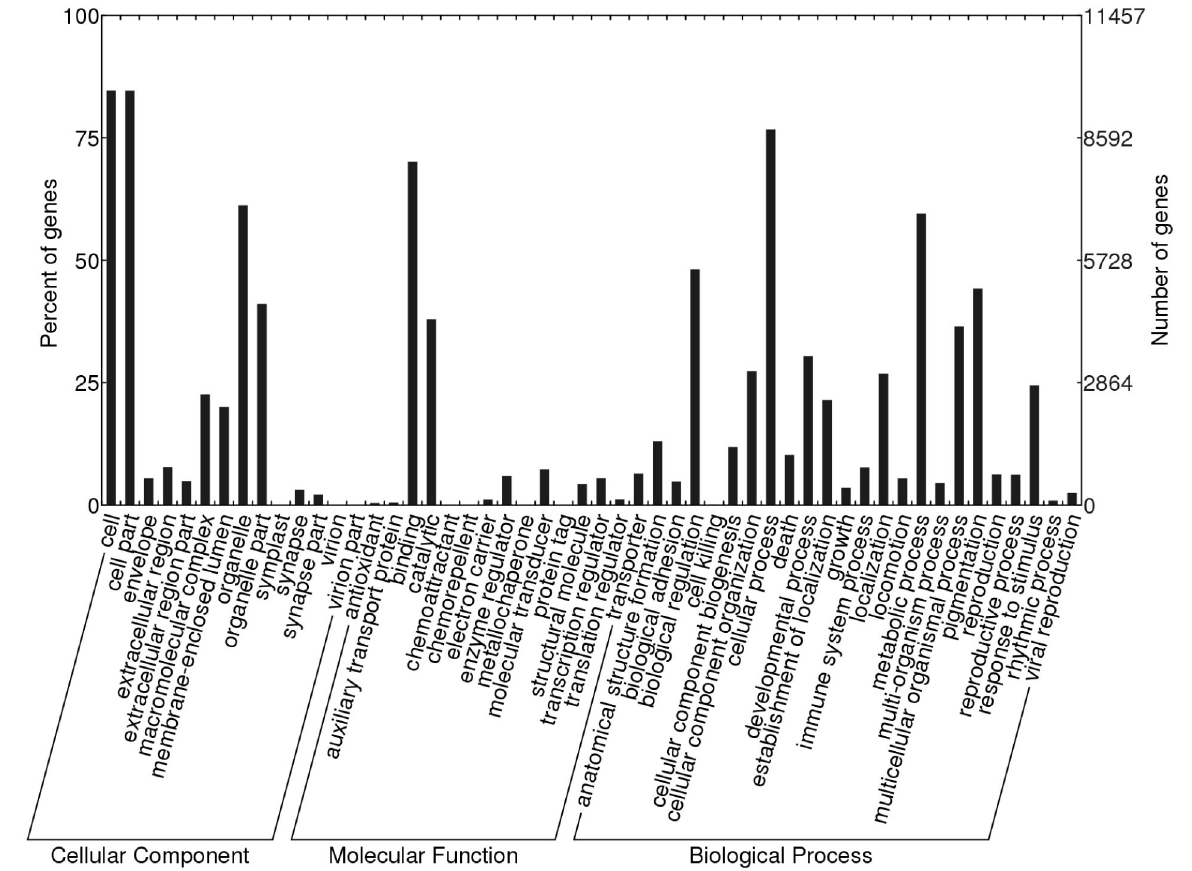
Figure 3. Distribution of Gene Ontology (GO) categories (level 2) of transcripts for O. margaretae . GO functional annotations are summarized in three main categories: cellular component, molecular function and biological